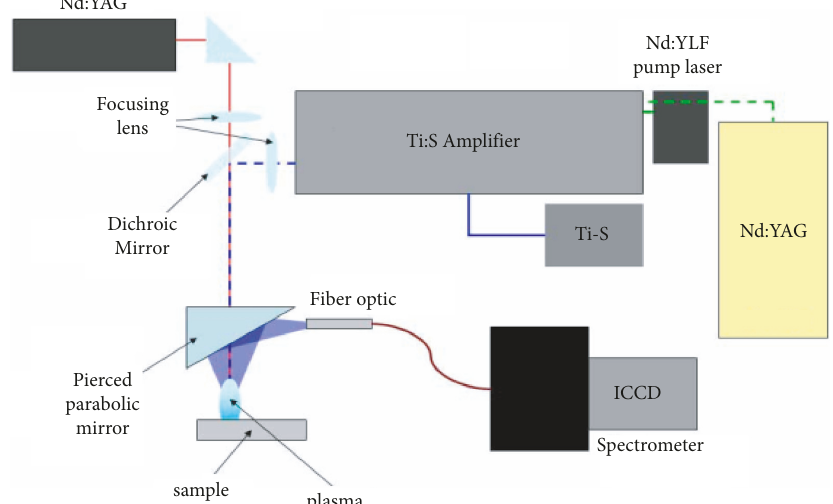
Figure 3: Schematic of the experimental setup of a femtosecond LIBS (adapted from [26]).